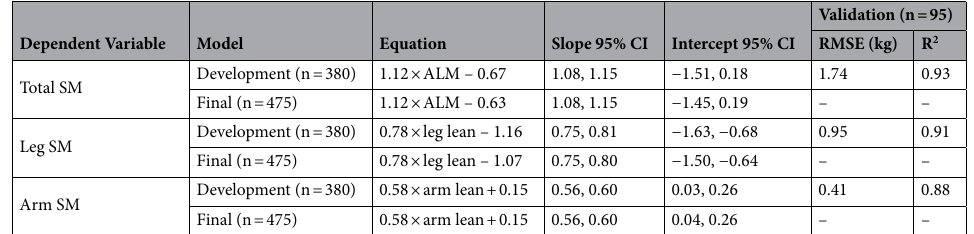
Table 3. Developed SM mass prediction models. ALM and lean mass units are in kg. ALM appendicular lean mass, RMSE root mean square error, SM skeletal